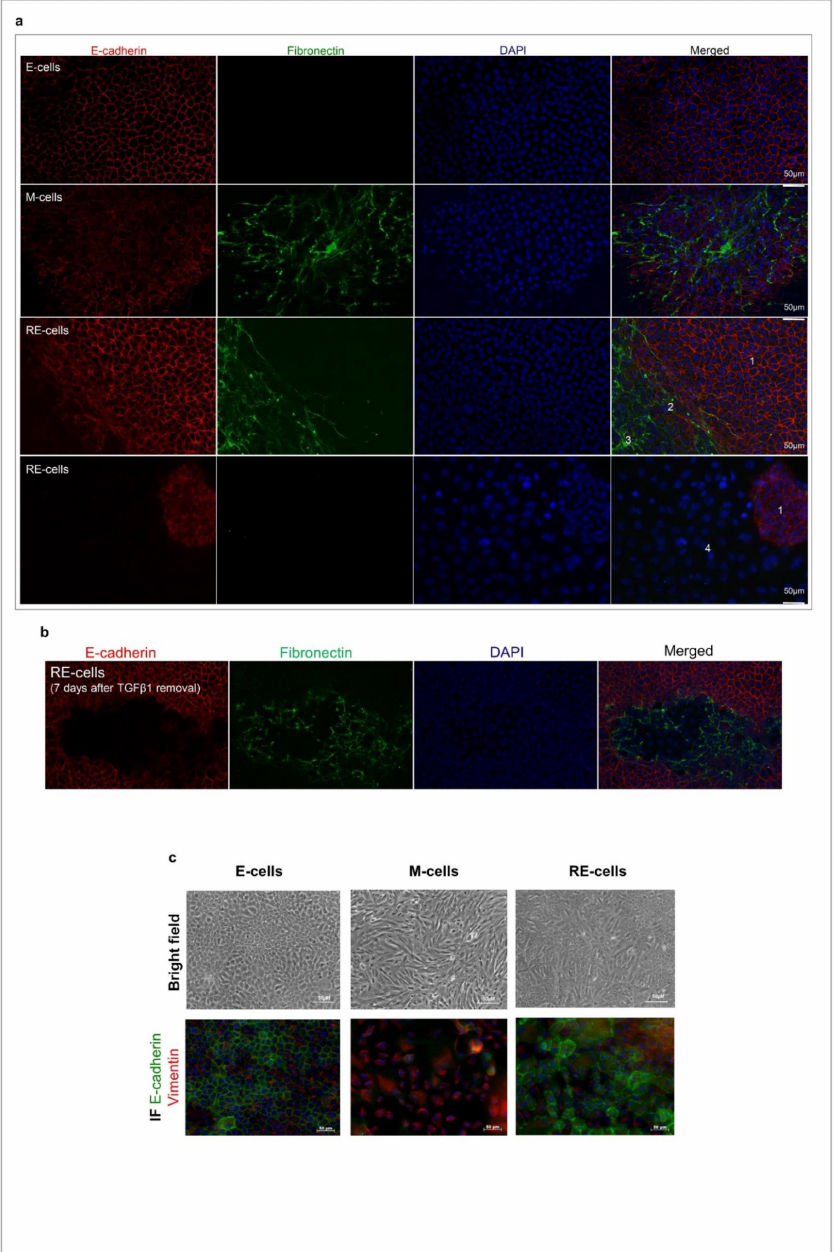
Figure 2. RE cells are a mixture of different cellular subpopulations. ( a ) Immunofluorescence staining for E-cadherin (red), Fibronectin (green) and DAPI (blue) of E, M and RE cells. Four different subpop- ulations were identified: 1: Ecad+/Fn − ; 2: Ecad+/Fn+; 3: Ecad − /Fn+ and 4: Ecad − /Fn − ).( b ) RE cells retain their E-cadherin or Fibronectin staining heterogeneity even if reversion time is longer than 4 days. Immunofluorescence images are for RE cells grown for 7 days after TGF β 1 removal from the culture medium. ( c ) Brightfield images of MCF10A E, M and RE cells (upper panel) and immunofluorescence staining for E-cadherin (green) and Vimentin (red) of MCF10A E, M and RE cells (bottom